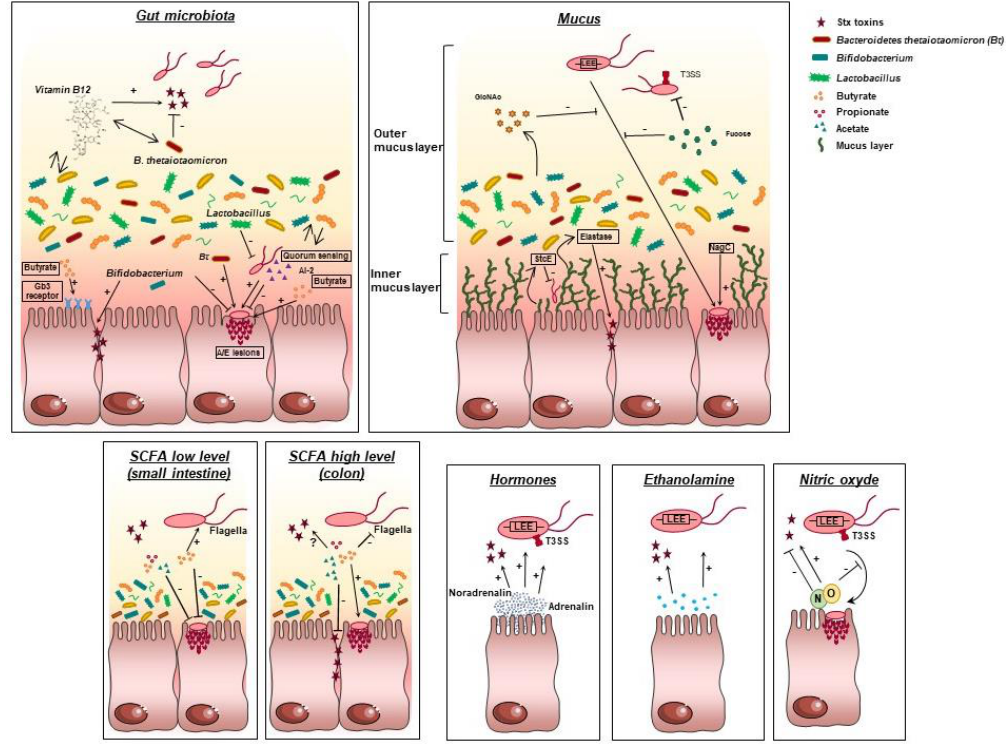
Figure 3. Influence of biotic factors on EHEC virulence. EHEC have evolved several strategies to modulate the expression of their virulence factors in response to biotic factors from the gut